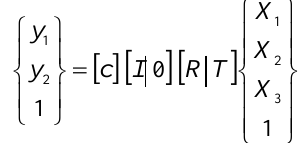
Figure 3. Global